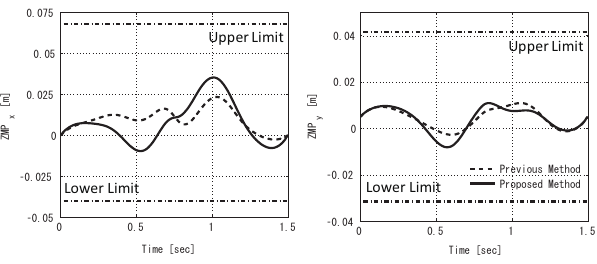
Figure 9. Comparison of the planned ZMP trajectories in Environment 2 (solid line: trajectories using the proposed method; dotted line: